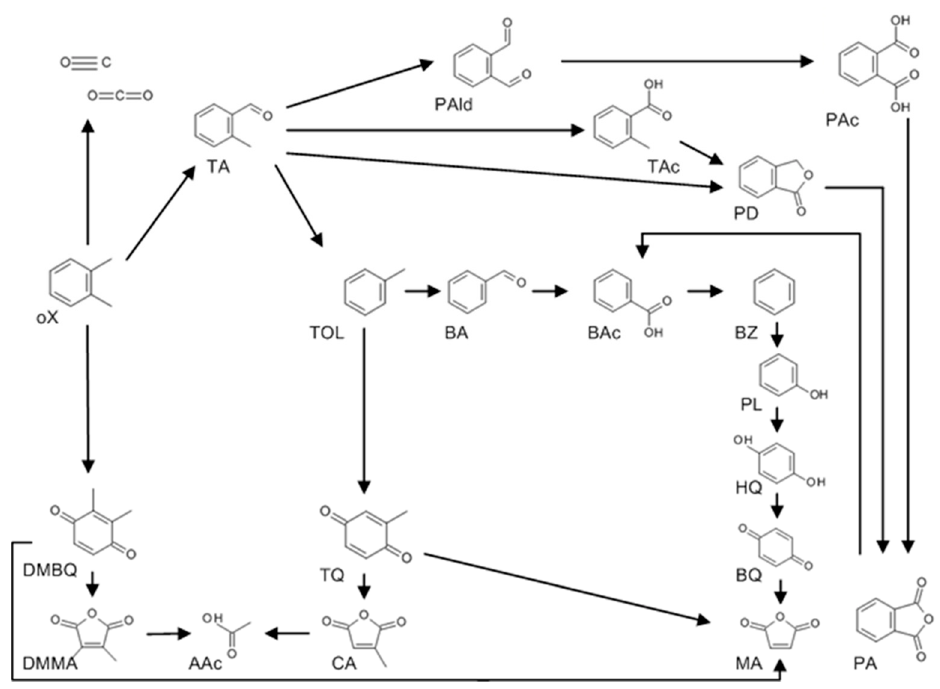
Figure 1. Reaction scheme of o-xylene oxidation (adapted from [3]).